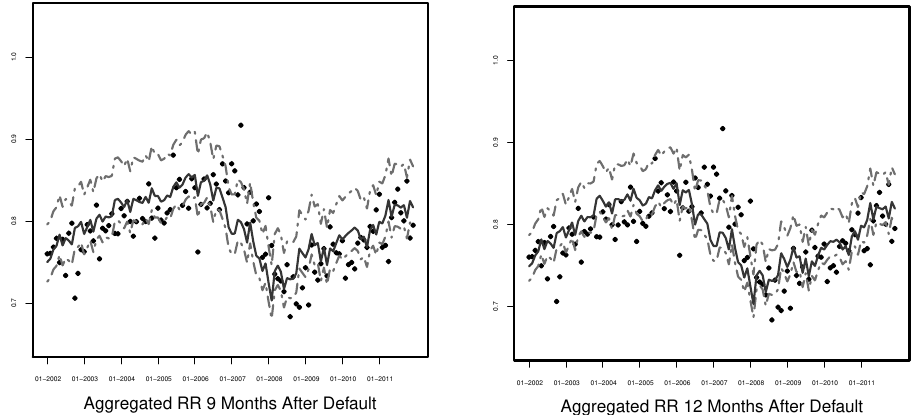
Figure 14. Monthly aggregated recovery rates with 99% prediction interval (grey dot-dash line) and the mean of the predictions (grey solid line) 9 and 12 months after default using empirical distributions for Model